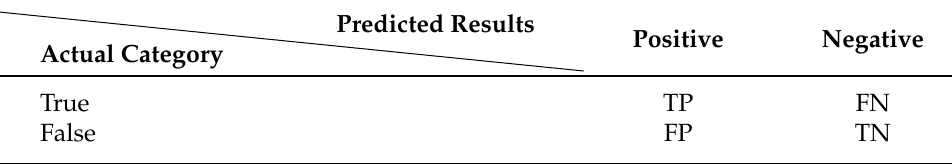
Table 5. Confusion matrices.